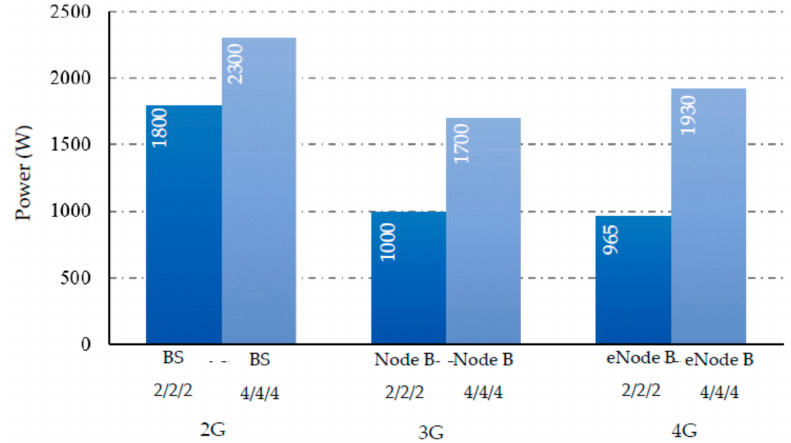
Figure 4. Total power consumption for common cellular macro-BSs from different cellular generations